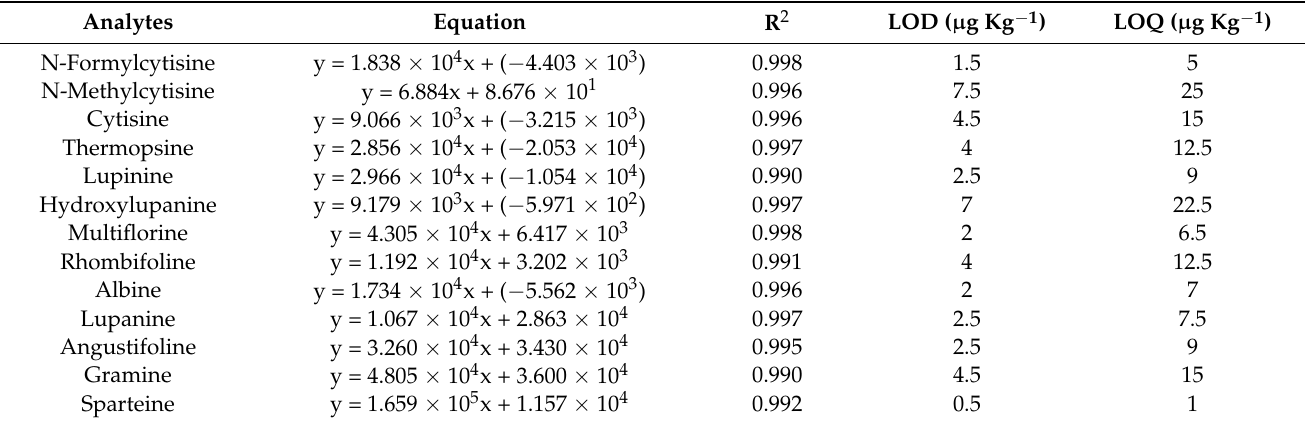
Table 1. Validation results: Linearity (Equation and R 2 ), Limit of Detection (LOD), Limit of Quantifi- cation